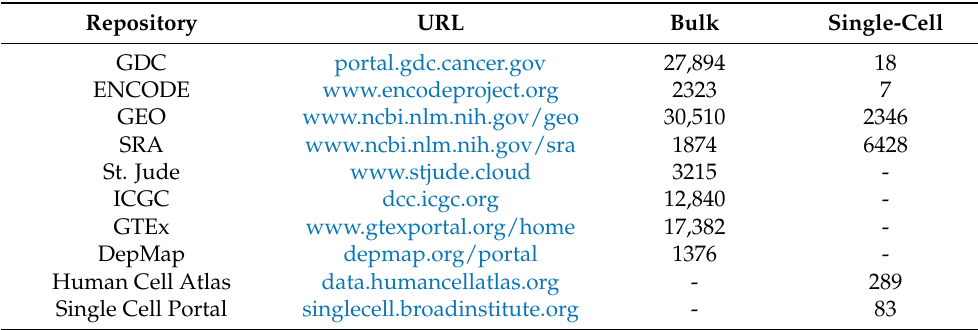
Table 1. The table reports the number of publicly available bulk and single-cell RNA-seq experiments. Data stored in reported repository are frozen at 15 March